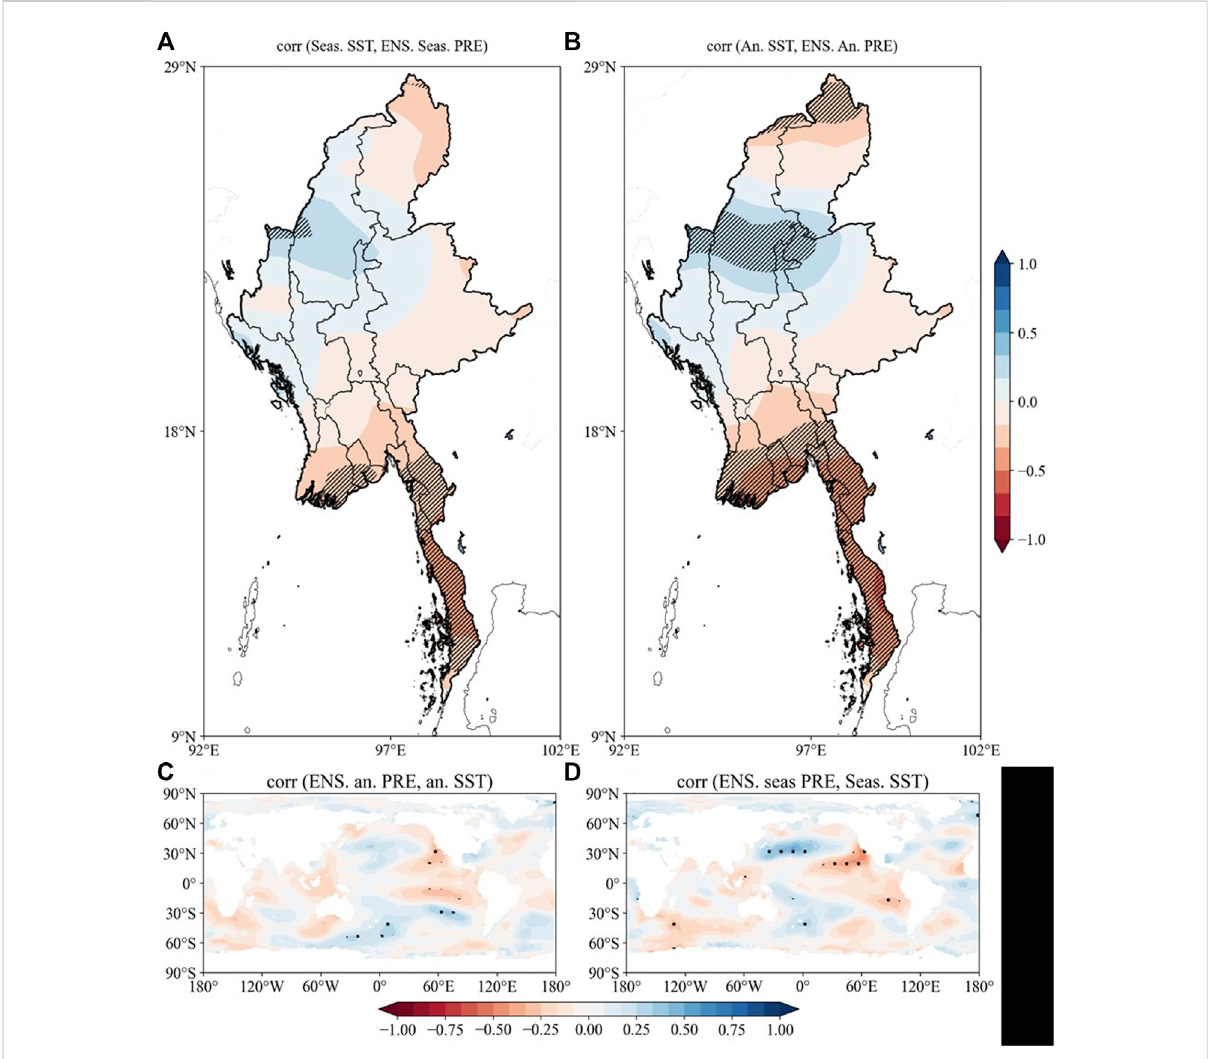
FIGURE 11 Spatialdistributionofthecorrelationcoef fi cientsbetweenENSPRE(annualandseasonal)andSSTduring1970-2014. (A) ENS-annual (B) Region ENS-annual (C) ENS-seasonal and (D) Region ENS-seasonal. Hatched area indicates 95% con fi dence